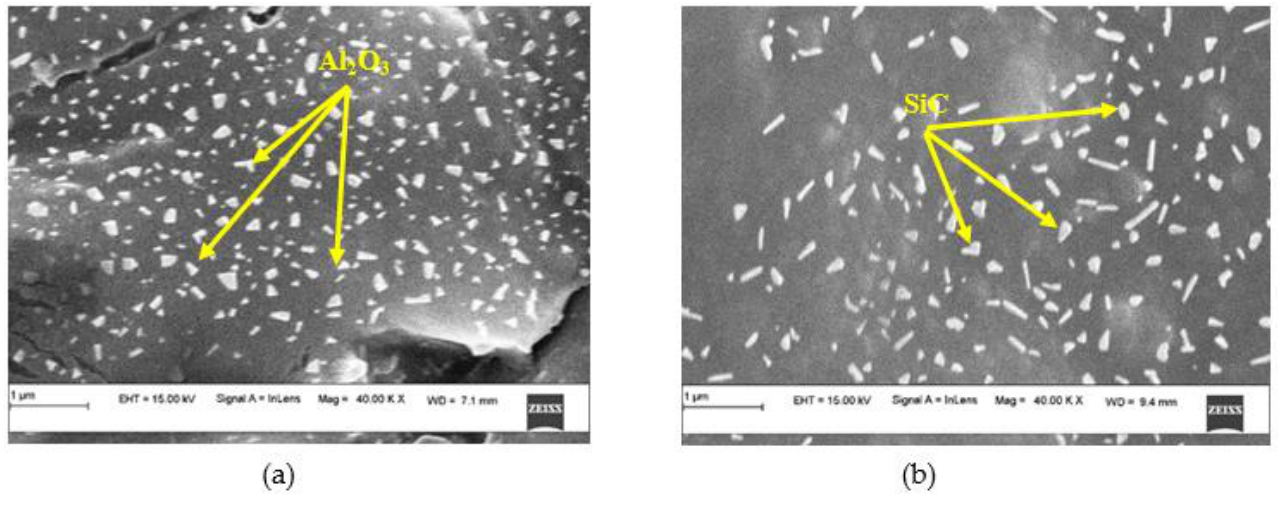
Figure 3. Distribution of nano-fillers: ( a ) 1.75 wt.% Al 2 O 3 ; ( b ) 1.25 wt.% SiC [50].